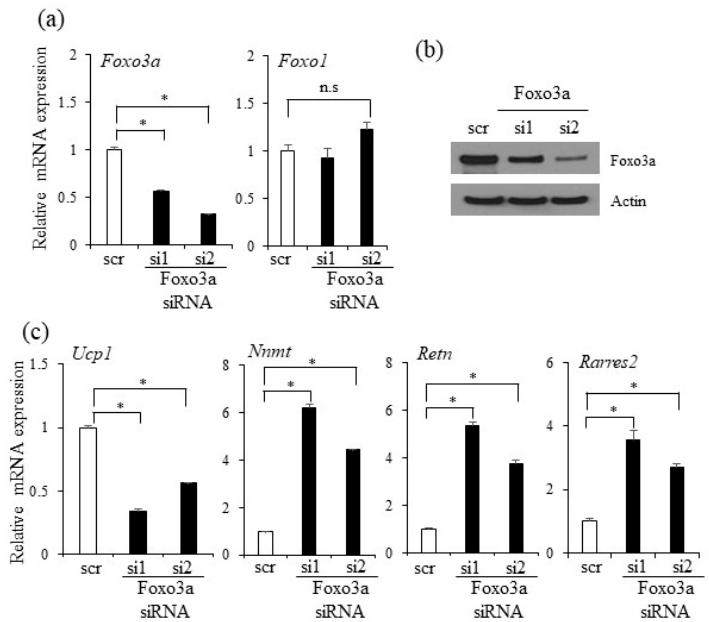
Figure 7. Foxo3a silencing decreases Ucp1 yet increases white adipocyte selective genes in C3H10T1/2 adipocytes. ( a ) Knockdown of Foxo3a by two independent siRNAs (si1 and si2) reduced the expression of Foxo3a but not Foxo1 compared to the scrambled non-specific control (scr) siRNA-transfected C3H10T1/2 cells. ( b ) Two independent Prdm4-specific siRNAs decrease Foxo3a protein expression. ( c ) Knockdown of Foxo3a decreases the expression levels of Ucp1 yet increases Nnmt, Retn, and Rarres2 mRNA expression compared to the scrambled control (scr) siRNA-transfected cells. Each experiment was carried out in triplicate. Data represent means ± s.e.m. Statistically significant differences were determined using Student’s t -test (* p < 0.05).